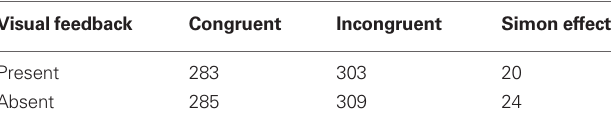
Table 3 | experiment 3, mean rTs and Simon effects as a function of visual and auditory